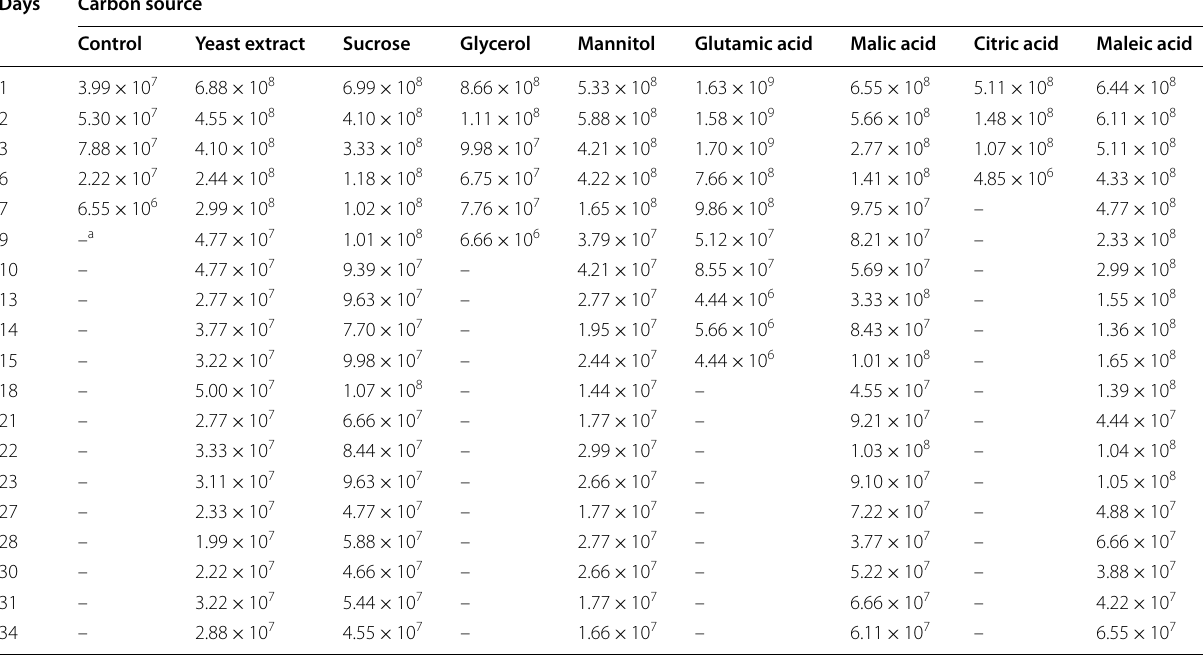
tional file 1: Table S3). Field trials performed in areas without history of